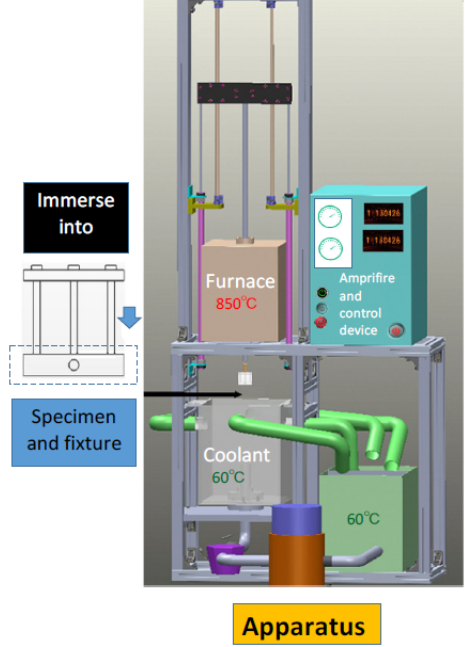
Figure 4. Measurement equipment.